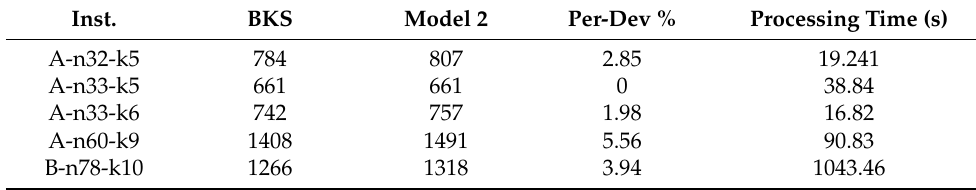
Table 2. VRP result of M 2 .